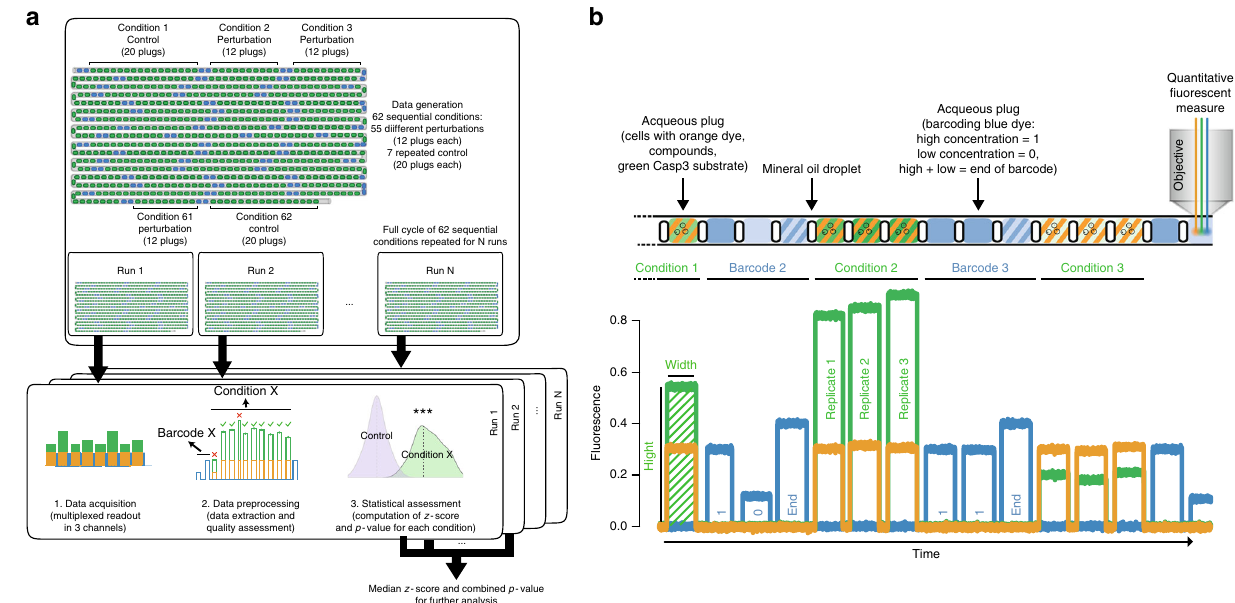
Fig. 2 General work fl ow of data acquisition and processing. a Different conditions are generated sequentially with multiple replicates (aqueous plugs) produced for each condition and collected in a tube. The whole experiment (run) is repeated multiple times and data for each run are processed separately and then combined. b Example of a plug sequence and corresponding readout. Each aqueous plug is generated by mixing the following components: cells (with orange- fl uorescent dye to verify the proper mixing of all components), caspase-3 substrate and one or two compounds. Plugs of each tested condition are preceded by binary barcode plugs to encode the corresponding identi fi cation number (high concentration of blue fl uorescent dye = 1, low concentration = 0, followed by an end of barcode